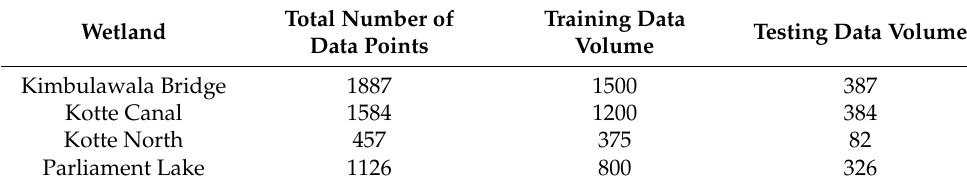
Table 3. Train-Test Data Split.